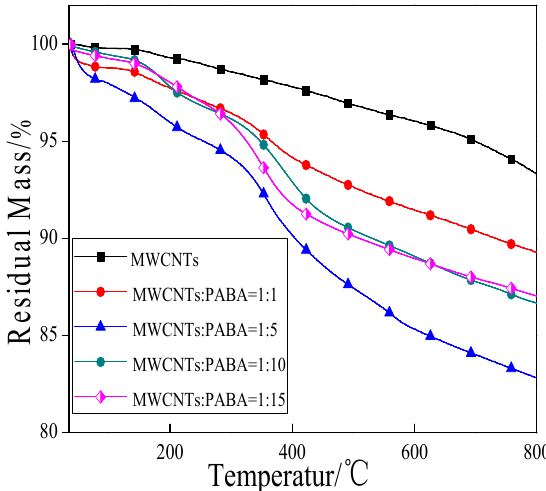
Figure 4. TGA curves of prime MWCNTs and PABA-modified MWCNTs.